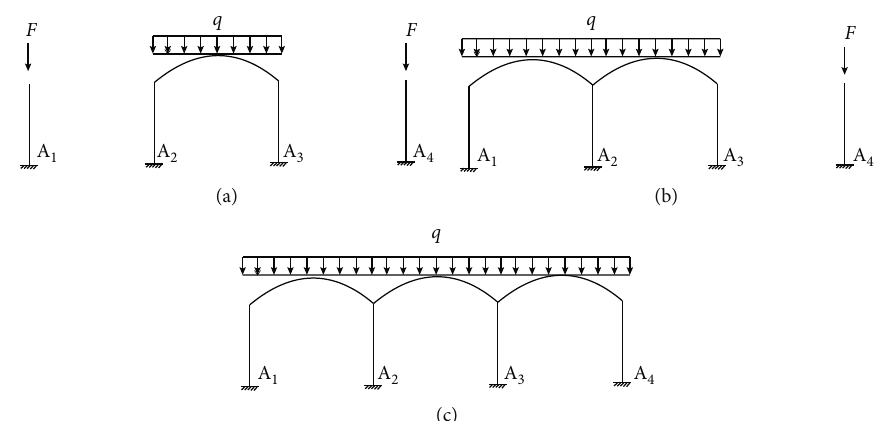
Figure 14: Changes in the force of the structural load-bearing system. (a) Middle arch of the secondary lining buckle. (b) Left arch of the secondary lining buckle. (c) Right arch of the secondary lining buckle.